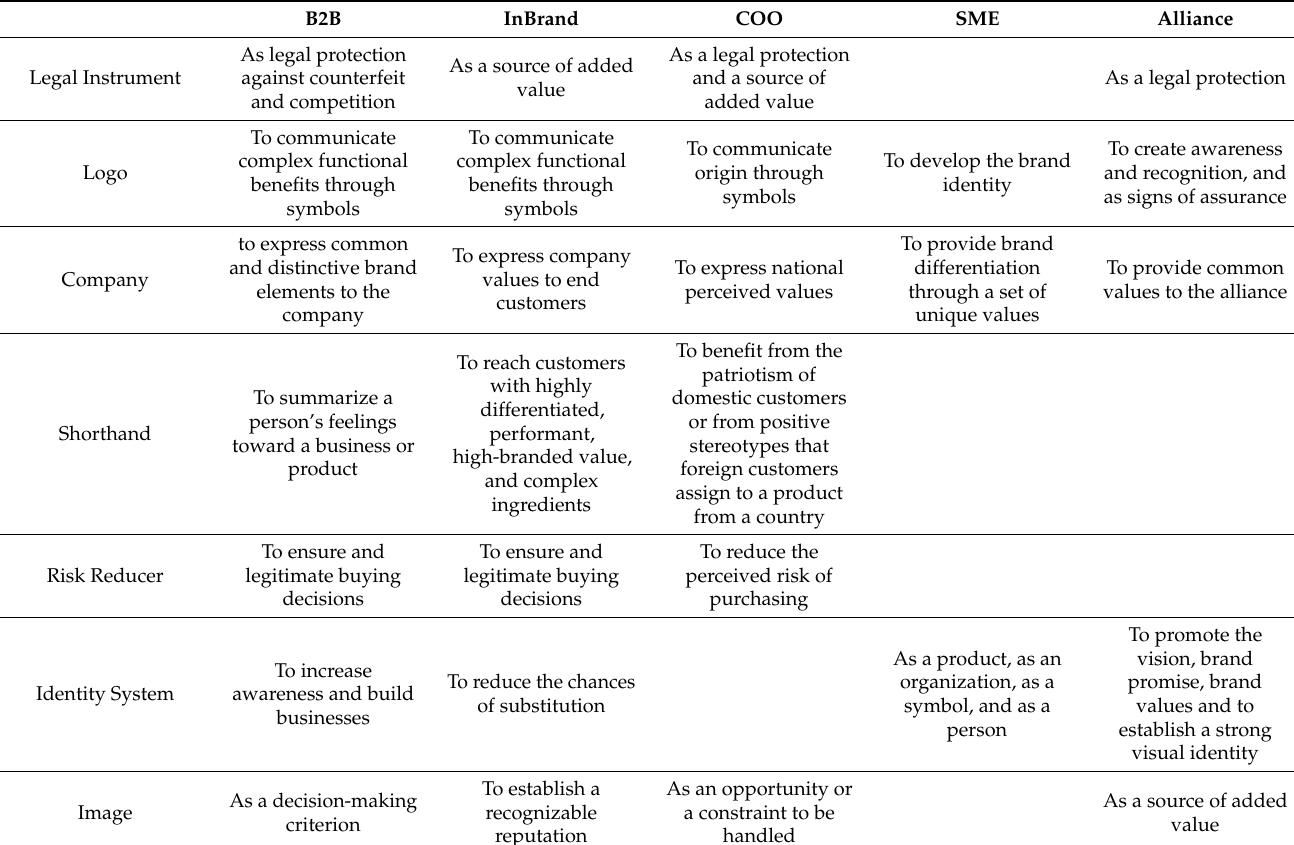
Table 2. Review of the 12 dimensions that define a brand according to B2B, Ingredient Brand, COO, SME, and Alliance